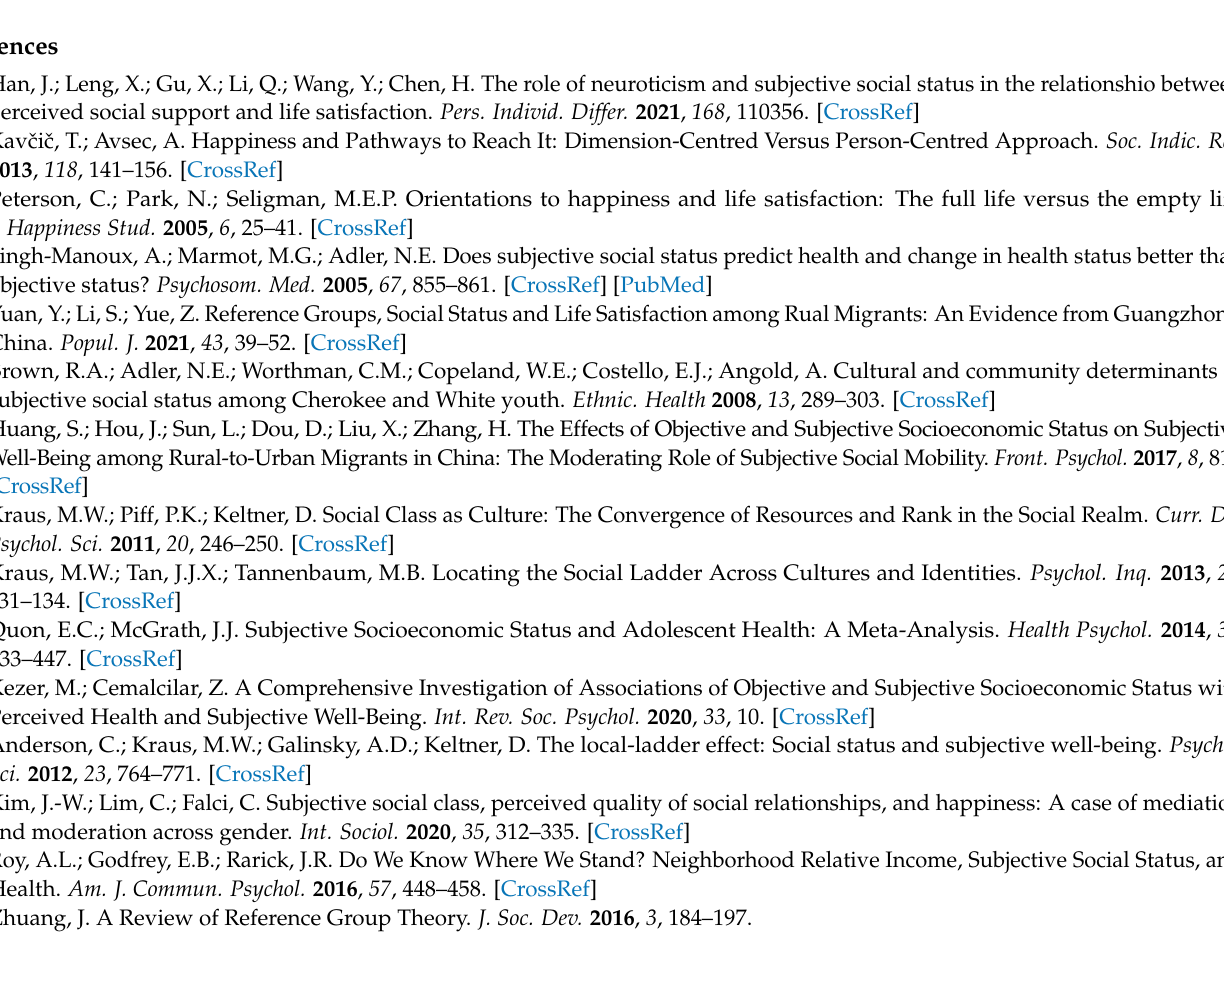
Table S2: KMO and Bartlett test results; Table S3: Results of factor